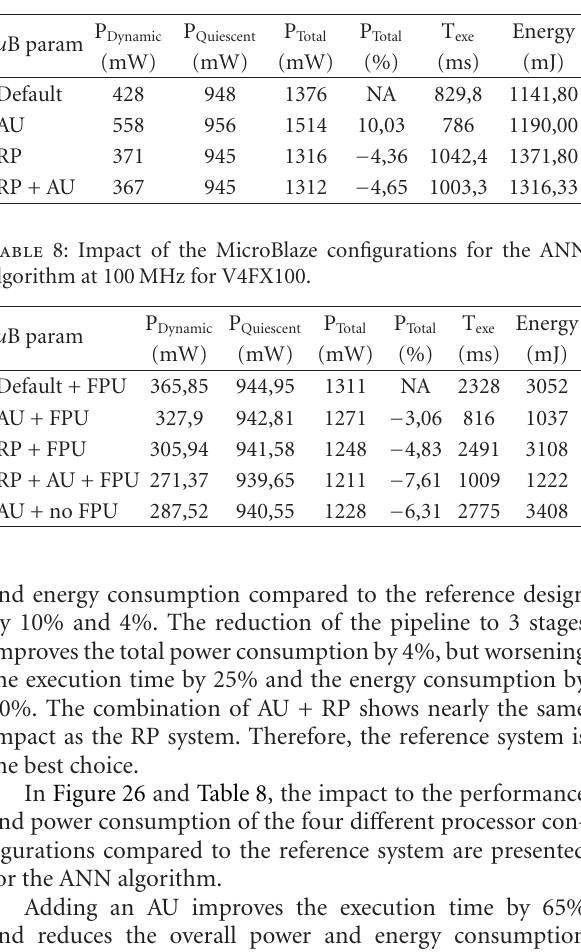
Figure 25: Impact of the MicroBlaze configurations for the DIALIGN algorithm. Table 7: Impact of the MicroBlaze configurations for the DIALIGN algorithm at 100 MHz for V4FX100.